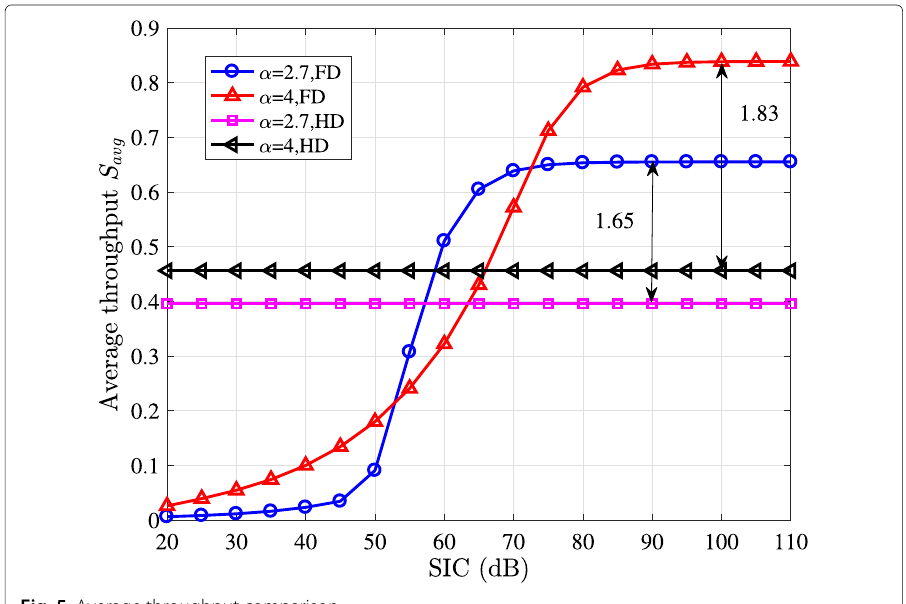
Fig. 5 Average throughput